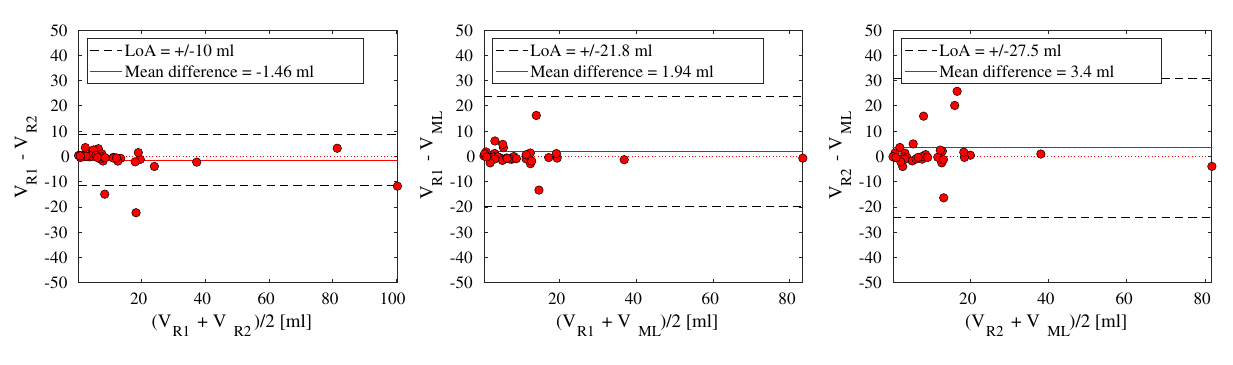
Figure 4. Bland-Altman plots of estimated primary tumor volume [ml] between raters and machine learning. Left: Rater 1 tumor volume ( V R 1 ) compared to rater 2 tumor volume ( V R 2 ). Middle: Rater 1 tumor volume ( V R 1 ) compared to machine learning tumor volume ( V ML ). Right: Rater 2 tumor volume ( V R 2 ) compared to machine learning tumor volume ( V ML ). Dashed lines indicate limits of agreement (LoA), and the solid red line represents the mean